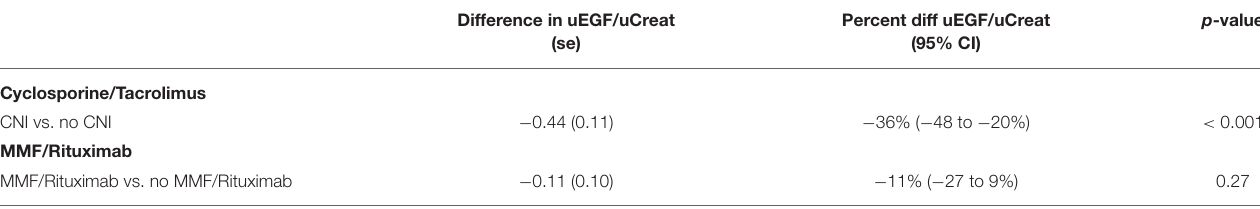
TABLE 3 | Comparisons based on linear mixed effects models with outcome log(uEGF/uCreat), random intercept, fixed effect for age, Cyclosporine/Tacrolimus, and MMF/Rituximab.